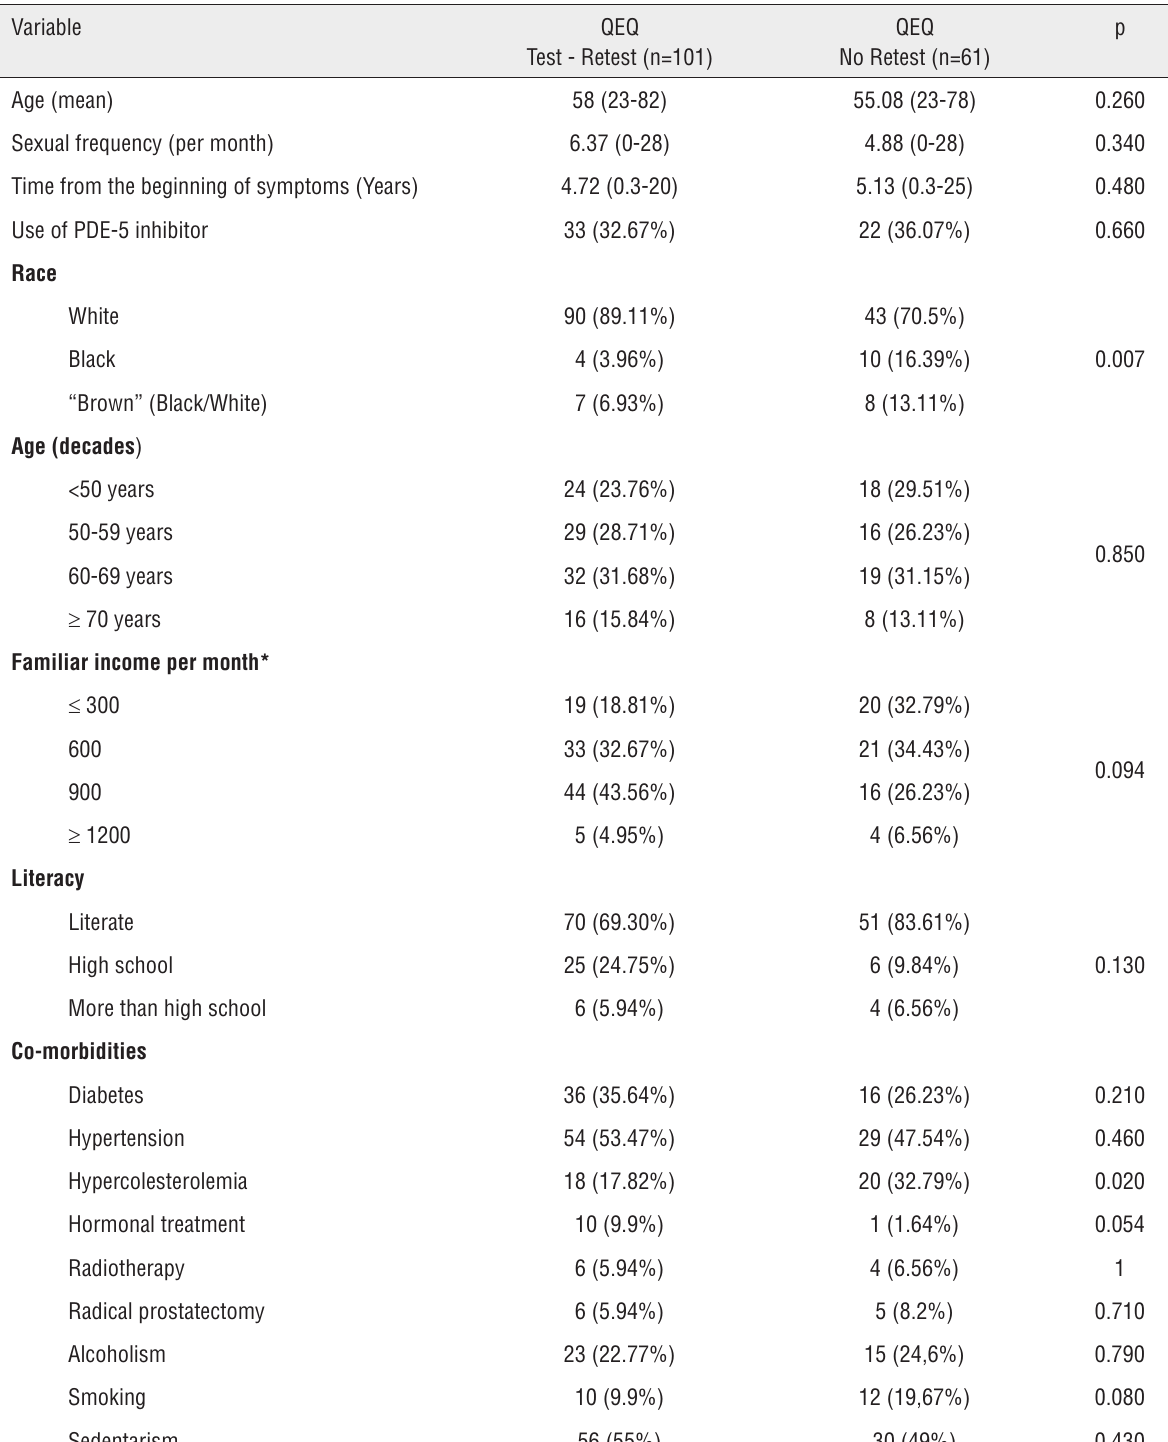
Table 1 - Caracteristics of patients with erectile